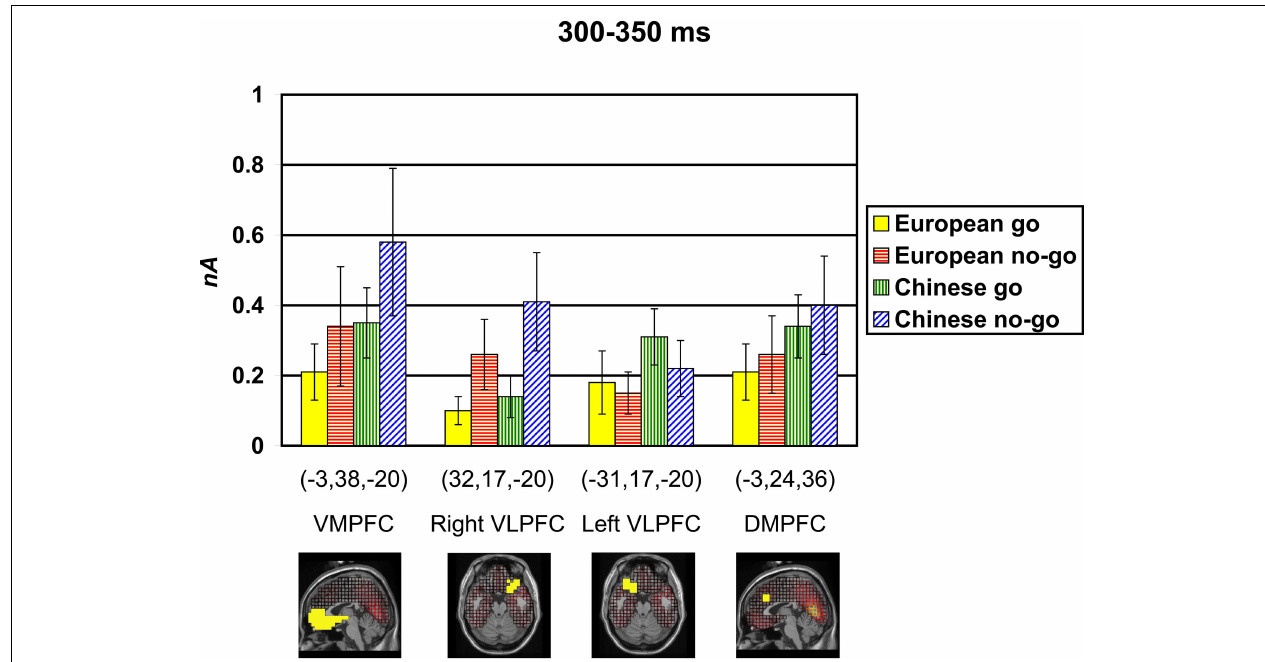
FIGURE 5 | Modeled source activations (in nA ) and ROIs displayed using the Montreal Neurological Institute (MNI) average adult MRI scan for the peak N2 interval of 300–350 ms in ventromedial prefrontal cortex (VMPFC; − 3, 38, − 20), right ventrolateral prefrontal cortex (VLPFC: 32, 17, − 20), left